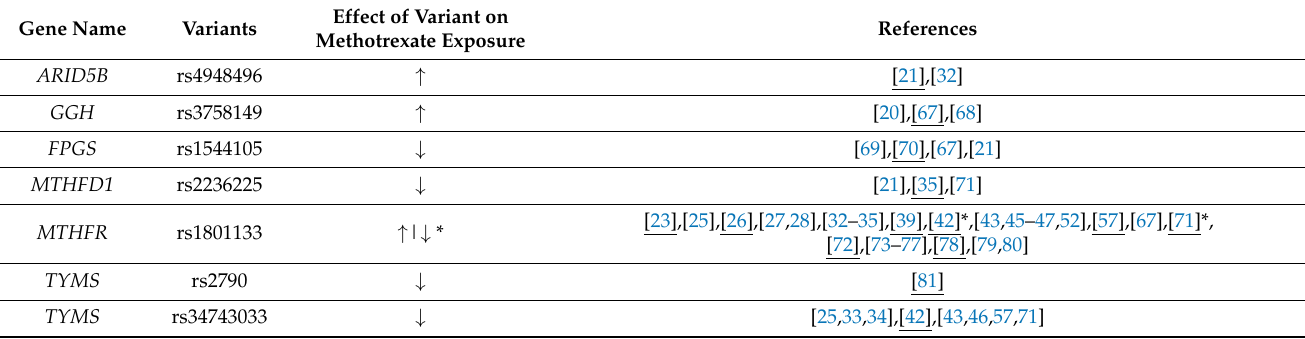
Table 2. Folate Pathway Genes That Significantly Affect Methotrexate